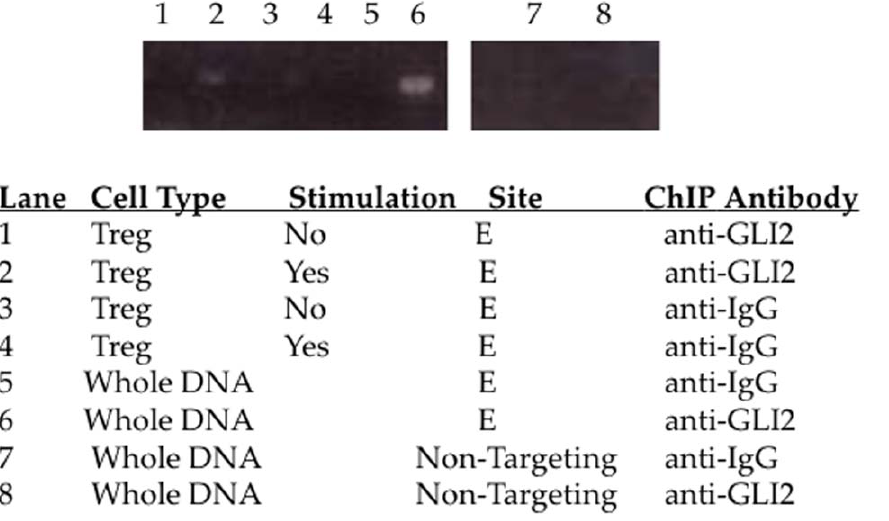
Figure 5. GLI2 binds to the human TGF- b 1 promoter. Chromatin immunoprecipitation (ChIP) was done to assess the binding of GLI2 to the human TGF- b 1 promoter. Primary human regulatory CD4 + CD25 hi T cells were negatively isolated and stimulated with a CD3/ a CD28-coated beads overnight. PCR was done to assess GLI2 binding. Whole DNA was used as a positive control for the PCR. GLI2 bound to the TGF- b 1 promoter at ‘Site E’ in the human TGF- b 1 promoter. GLI2 did not bind to a non-targeting region in the human IL-10 promoter (Lane 8). address off-target effects (Figure 4C). These results indicate that GLI2 is important in regulating TGF- b 1 transcription in primary human Treg. The sorted Treg were CD3 + CD8 - CD4 + CD25 hi - FoxP3 + T cells. The purity of the Treg was more than 85% (Figure 4D).